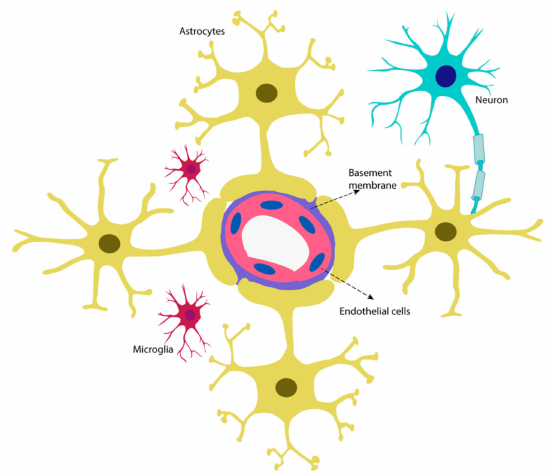
Figure 2. The neurovascular unit. Schematic representation of the cellular and non-cellular compo- nents of the neurovascular